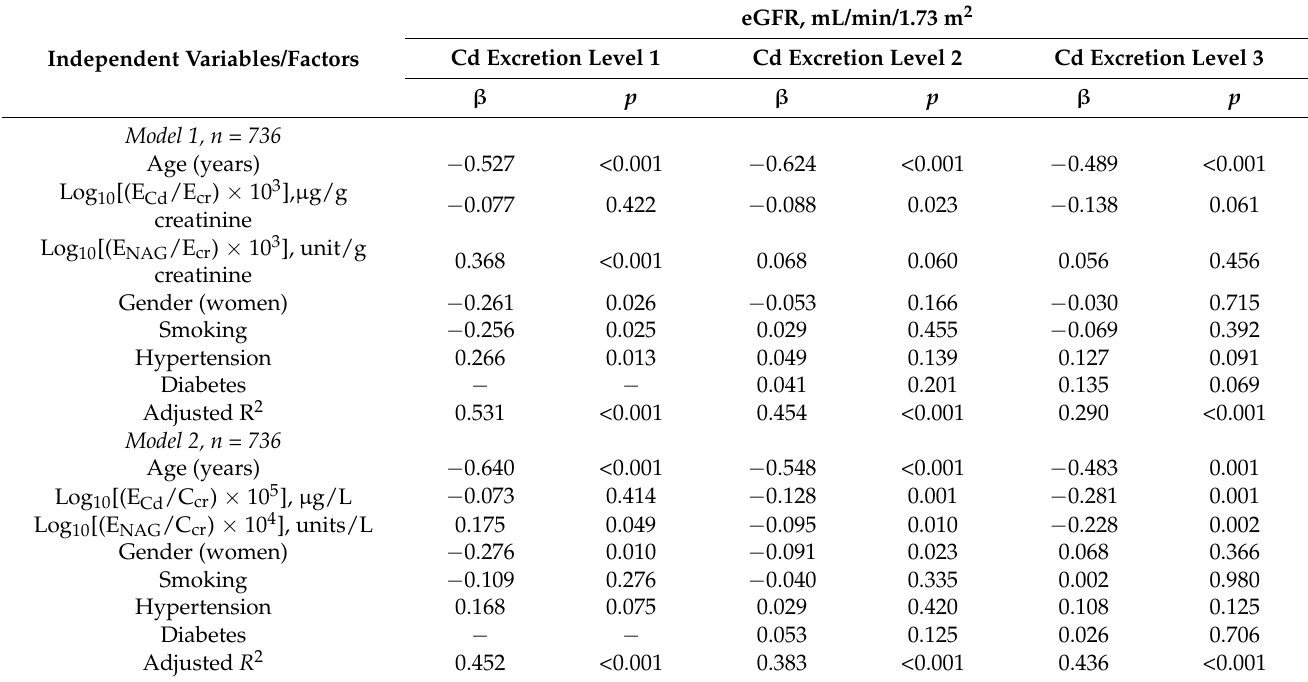
Table 3 presents two multivariable linear regression models of eGFR. As in Table 2, the models incorporated demographic factors and parameters of Cd and NAG excretion. E Cd and E NAG were normalized to E cr in model 1 and to C cr in model 2. Accordingly, subsets of subjects were defined by gradations of log[(E Cd /E cr ) × 10 3 ] in model 1 and log[(E Cd /C cr ) × 10 5 ] in model 2. In each model, age exhibited the greatest absolute value of standardized β (strength of association) at all three gradations of log[(E Cd /E cr ) × 10 3 ] or log[(E Cd /C cr ) × 10 5 ]. Table 3. Relationships of eGFR to demographic factors and parameters of Cd and NAG